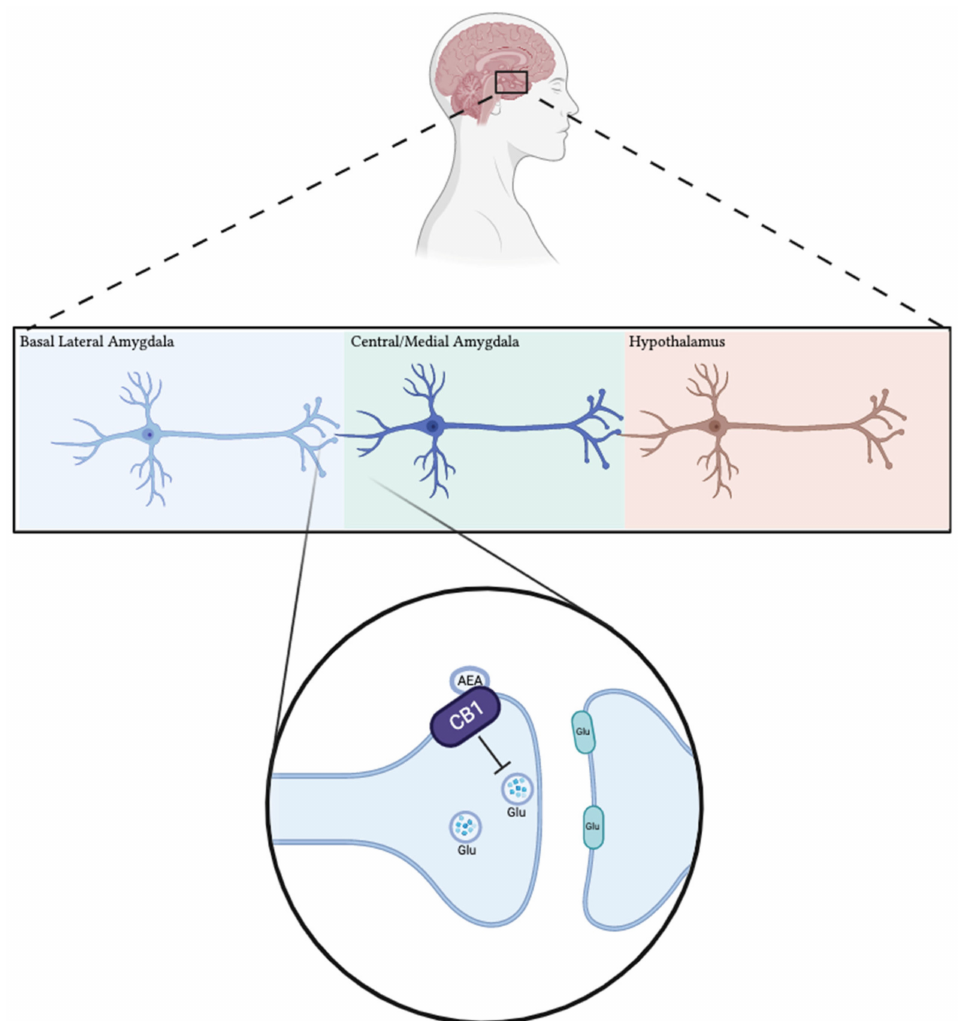
Figure 2. Cannabinoid receptors in the basolateral amygdala (BLA) modulate physiological stress response from the HPA by acting as a brake on glutamate release. Under basal conditions in BLA neurons, inhibitory cannabinoid receptors are activated by high levels of synaptic endocannabinoids, causing inhibition of glutamate release to neurons in the paraventricular nucleus of the hypothalamus. Stress conditions cause the hydrolysis of endocannabinoids (via FAAH), which decreases the activation of cannabinoid receptors and relieves inhibition of glutamate release to the